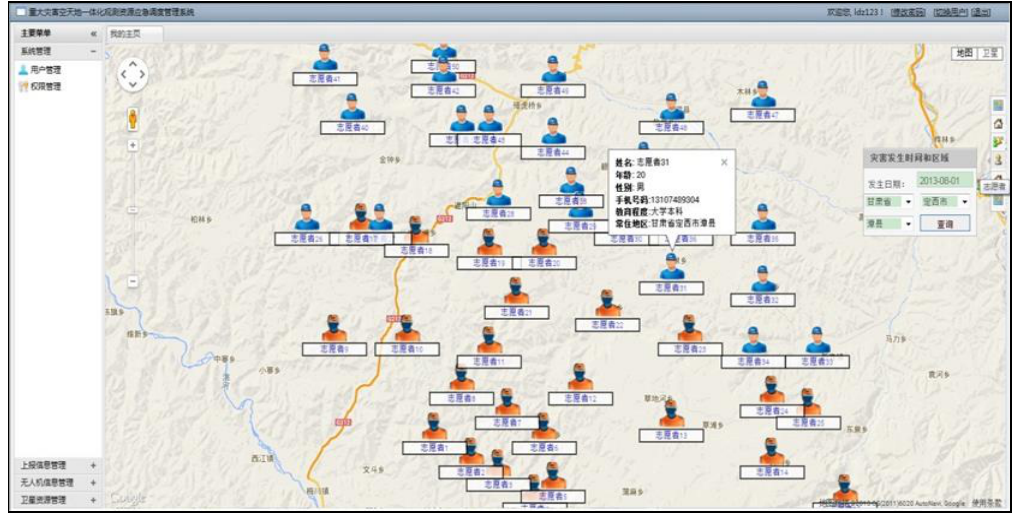
Figure 3 The emergency tracking result of the volunteers in Zhang